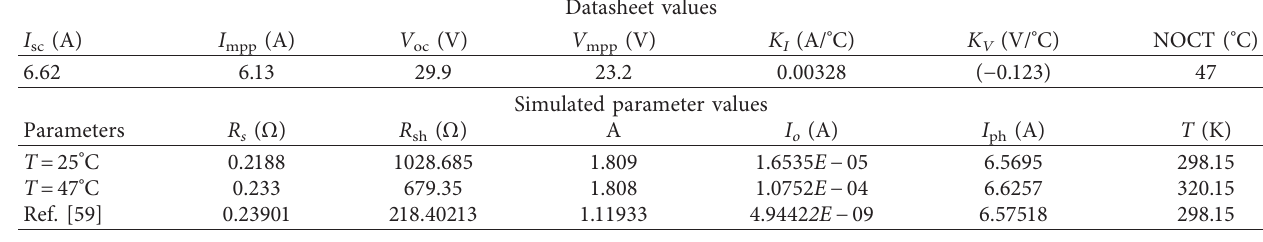
Table 11: Calculated parameters and data from simulations for KC200GT.